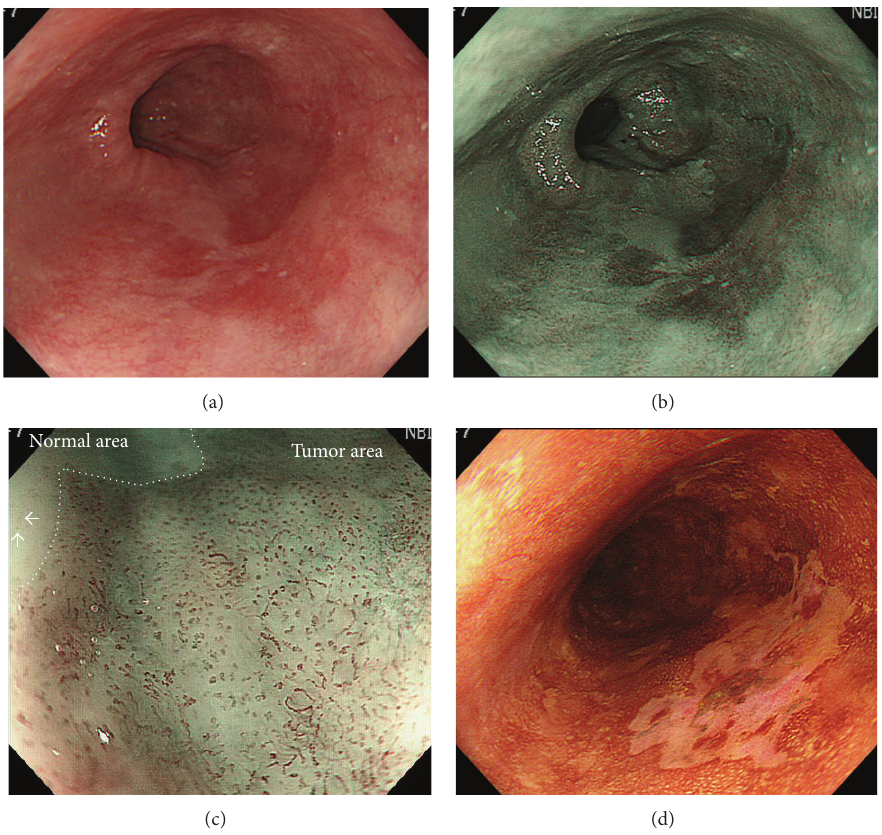
Figure 1: A representative lesion of superficial esophageal squamous cell carcinoma. (a) A flat-type lesion of reddish color could be observed at the two to seven o’clock position in the middle esophagus. (b) The lesion was clearly visualized as a 30 mm wide brownish area by using nonmagnifying endoscopy with narrow-band imaging. (c) Narrow-band imaging magnifying endoscopy shows an intervascular background coloration and increase in the number of abnormal microvessels (i.e., proliferation) in the tumor area compared with the normal area. Abnormal microvessels with morphological changes of dilation, tortuosity, change in caliber, and various shapes compared with normal intrapapillary capillary loops are also seen (white arrows). (d) On Lugol chromoendoscopy, the lesion is visualized as a Lugol-voiding area with a pink-color sign at 3min after spraying the iodine solution. The lesion was removed by endoscopic submucosal dissection, and the histology was squamous cell carcinoma invading up to the lamina propria